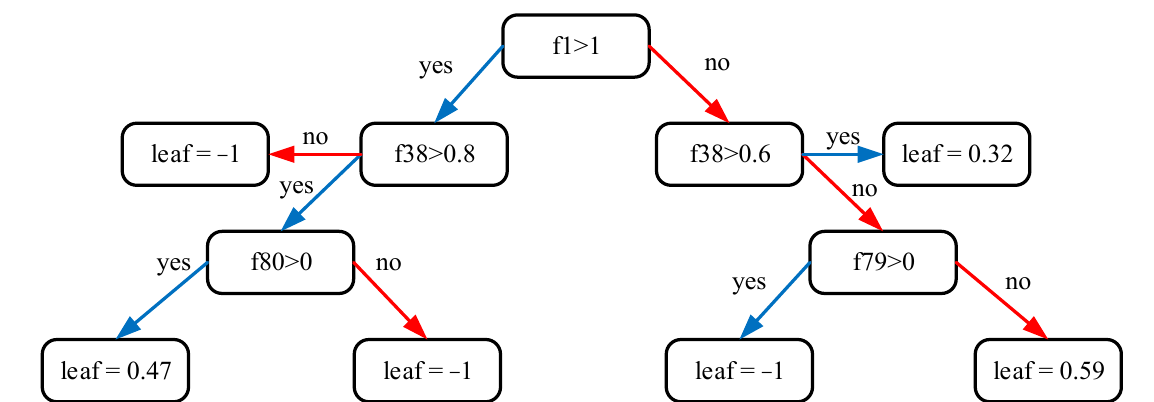
Figure 5. An example of one of the base classifiers of the XGBoost algorithm.